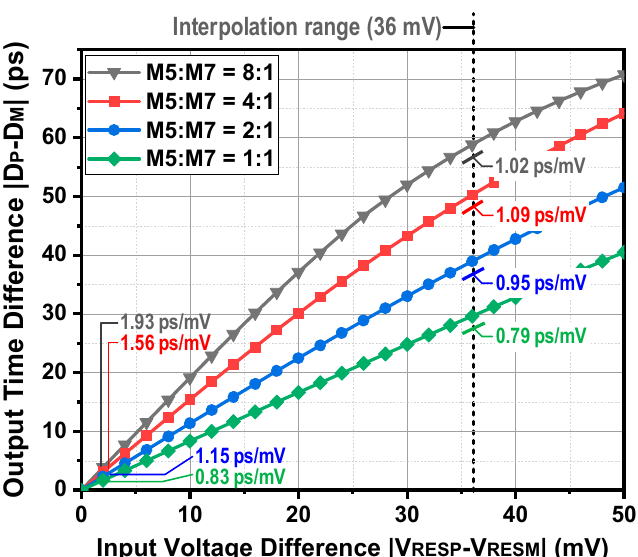
Figure 7. Output time difference of the VTC, D P -D M , versus various input voltages, V RESP -V RESM , according to the size ratios of M5 and M7 of the VTC.